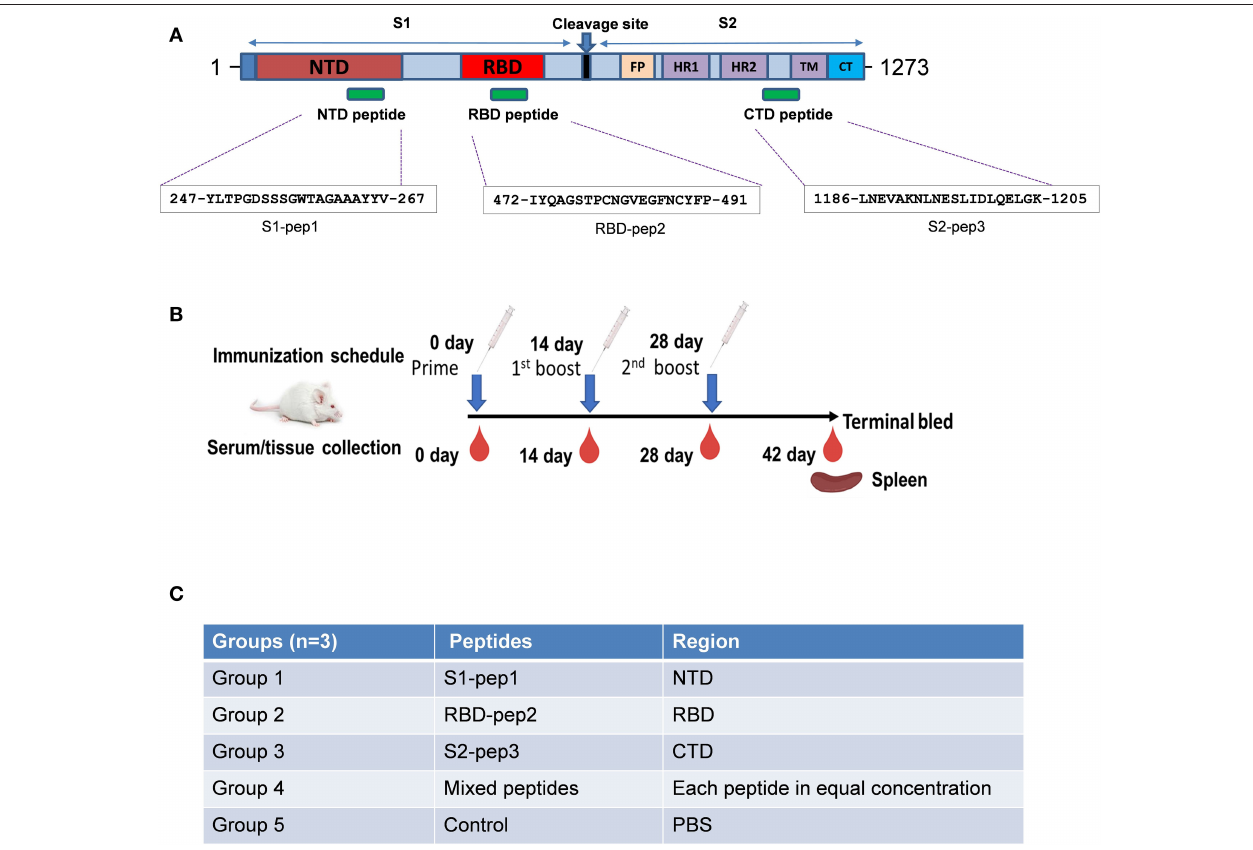
FIGURE 1 | Schematic of SARS-CoV-2 spike protein and immunization schedule. (A) Full-length spike protein depicting sequence location of S1-pep1, RBD-pep2, and S2-pep3. (B) Immunization scheme and sample collection schedule in BALB/c mice. (C) Immunization strategy in different